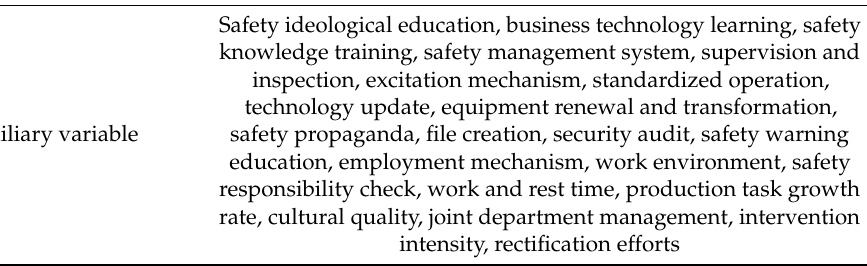
Figure 12. Dynamics flow diagram of grid H